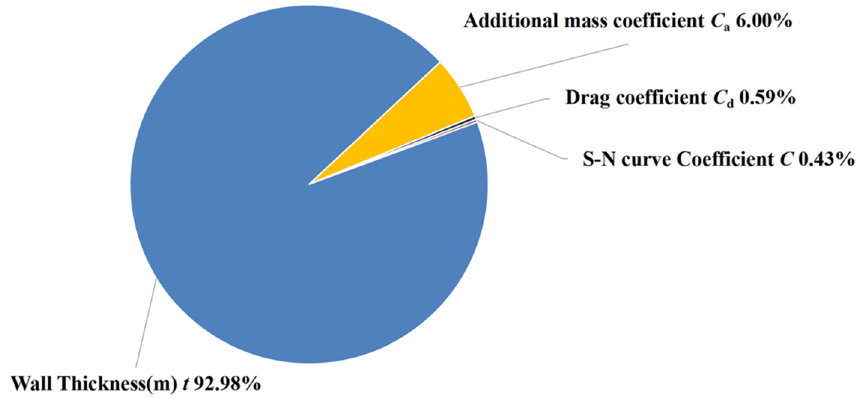
Figure 11. Effect of C d on fatigue damage.